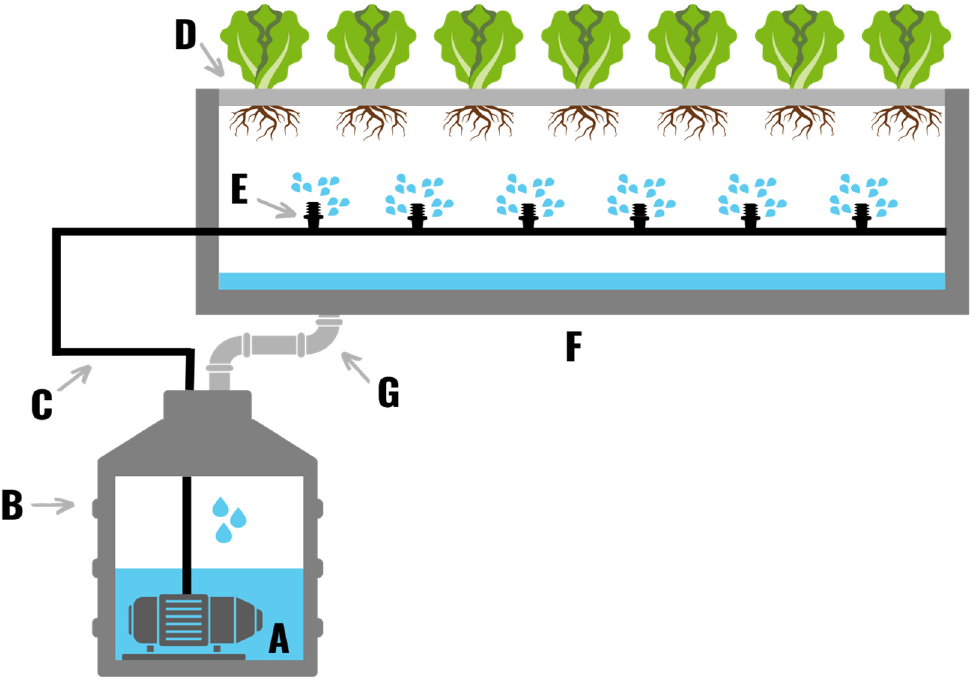
Figure 8. An aeroponic system consisting of a water pump ( A ), nutrient reservoir ( B ), watering line ( C ), a plant support plate ( D ), spray heads/nebulizers ( E ), a collection tray ( F ), and a return pipe ( G ). Plants are supported above the spray heads such that the roots of the plant are exposed to the air. Nutrient solution is misted onto the roots of the plants via the spray heads and runoff is collected and returned to the nutrient solution